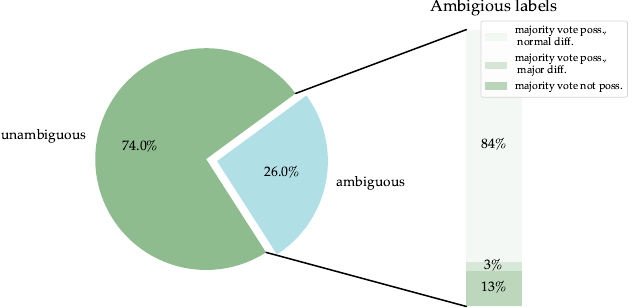
Figure 8. Listing of the different degrees of agreement in the evaluation and their share in the total number of repetitions. For “unambiguous” repetitions, all raters agree. For “ambiguous” repetitions, at least one does not agree with the rest. The category “ambiguous” can be further divided into repetitions where no majority vote is possible, repetitions where a majority vote is possible, but there are major differences in the given ratings and repetitions where a majority vote is possible, but just minor differences in the given